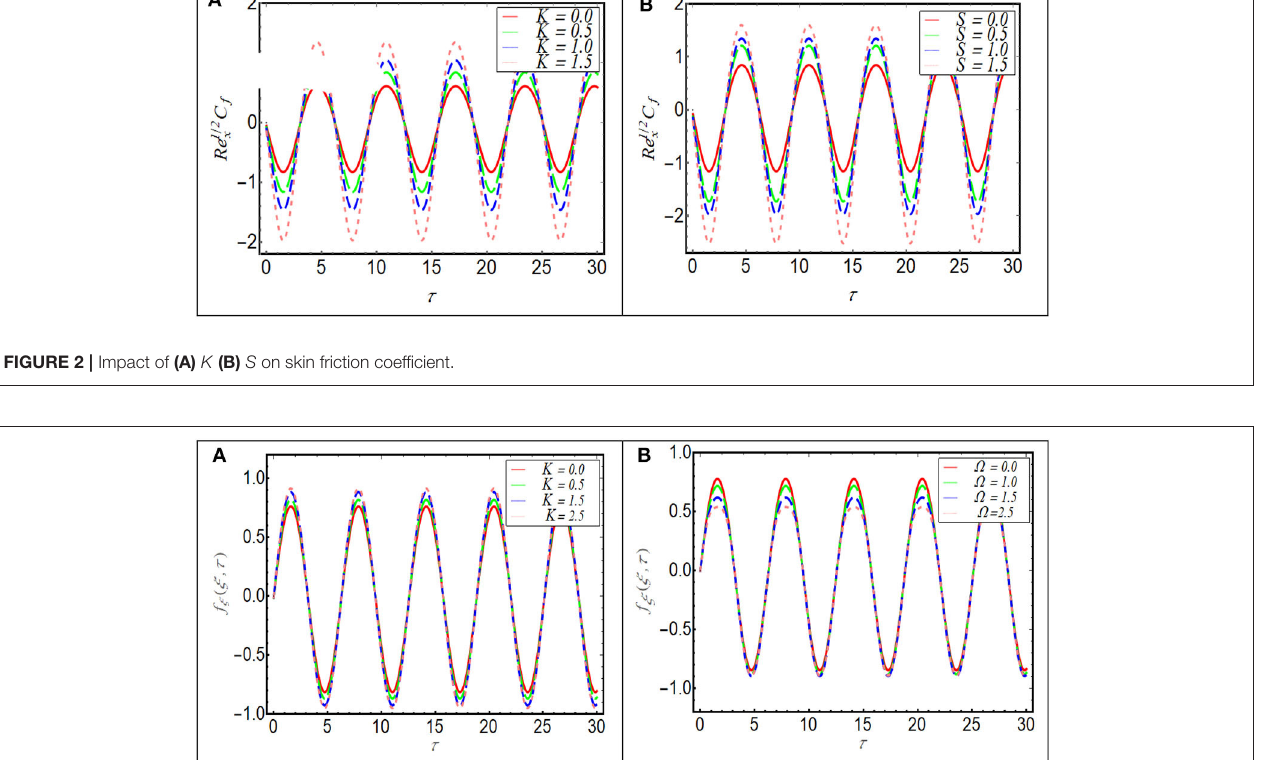
Frontiers in Physics |